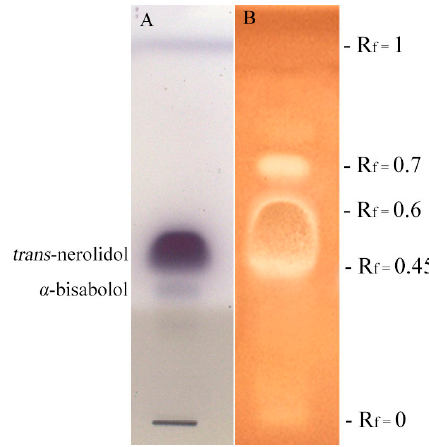
Figure 2. HPTLC (High Performance Thin Layer Chromatography) bioautographic assay performed for antibacterial activity on S. aureus , of M. splendens essential oil. R f : retention factor: it represents the ratio between the migration distance of a substance and the migration distance of the solvent front.